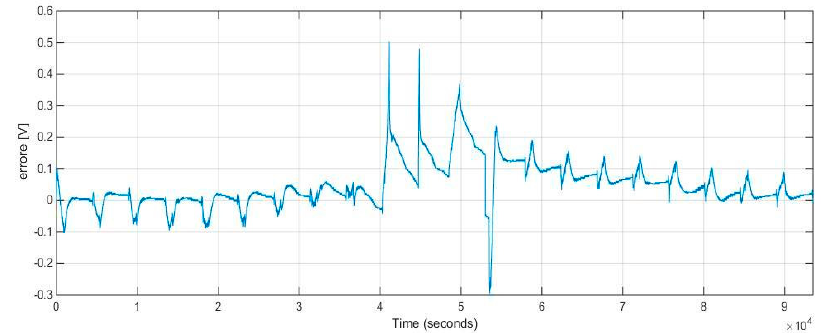
Figure 13. Measured voltage vs. simulated voltage.